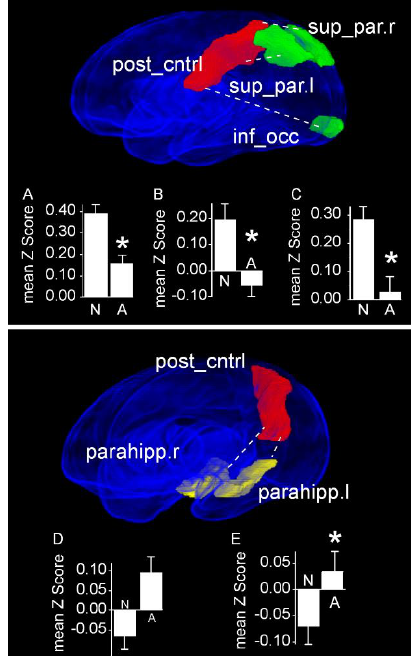
Figure 4. Region pairs exhibiting increased and decreased functional connectivities in infants with normal movement character compared with infants with monotonous movement character. Obliquely projected 3D reconstructions of MRI images of cerebral grey matter and identified parcellated regions derived from a neonatal atlas. Top: The left postcentral gyrus exhibits an increased rsFC with each of the ipsilateral and contralateral superior parietal cortices and the ipsilateral inferior occipital cortex. Bottom: The left postcentral gyrus exhibits a decreased rsFC with each of the ipsilateral and contralateral parahippocampal gyri. Dashed white lines depict connectivity relationships. Insets: Fisher-transformed Z-scores ± 1 SEM. ( A ) Postcentral gyrus and the right superior parietal cortex. ( B ) Postcentral gyrus and the left right superior parietal cortex. ( C ) Postcentral gyrus and inferior occipital cortex. ( D ) Postcentral gyrus and right parahippocampal gyrus. ( E ) Postcentral gyrus and left parahippocampal gyrus. N: Normal; A: Abnormal. * P FDR < 0.05. J. Clin. Med. 2019 , 8 , x FOR PEER REVIEW